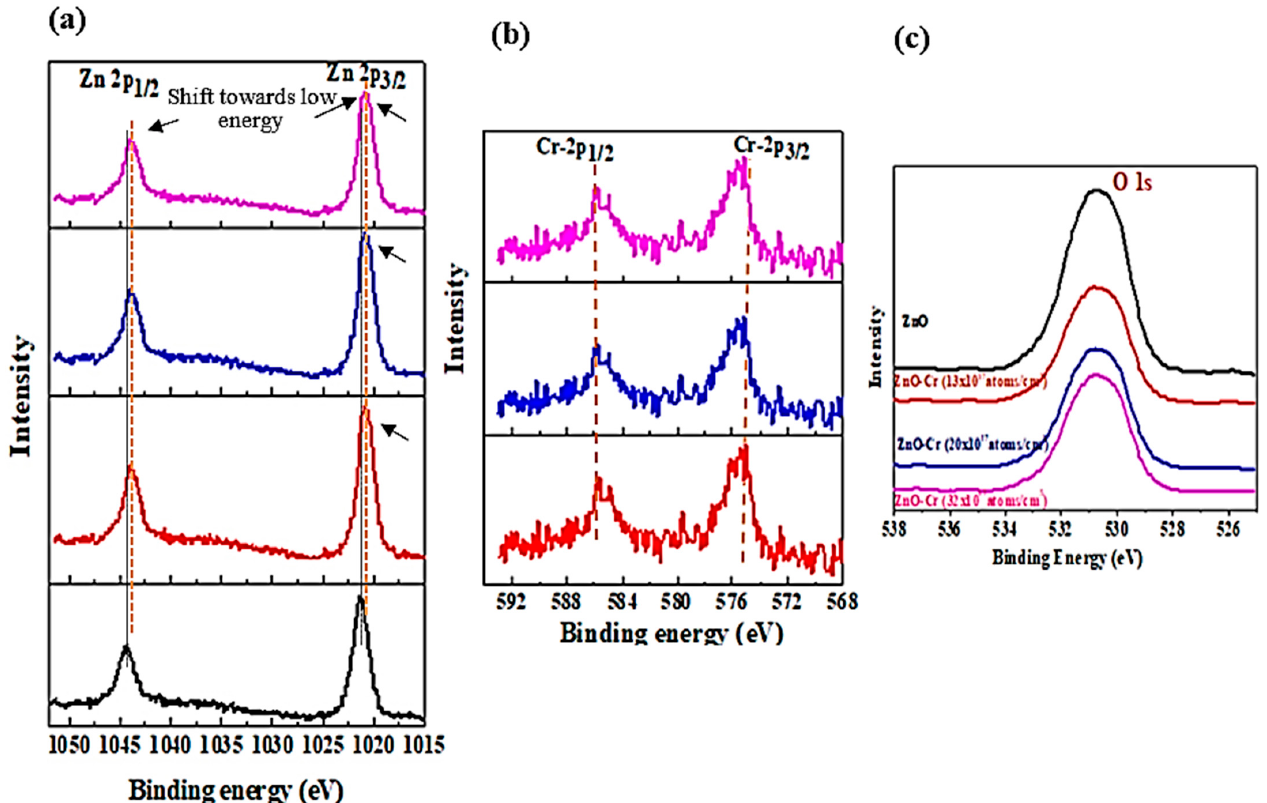
Figure 3. High-resolution X-ray photoelectron spectra for pristine and Cr-doped ZnO ( a ) Zn 2p ( b ) Cr 2p and ( c ) O 1s. 2p and ( c ) O